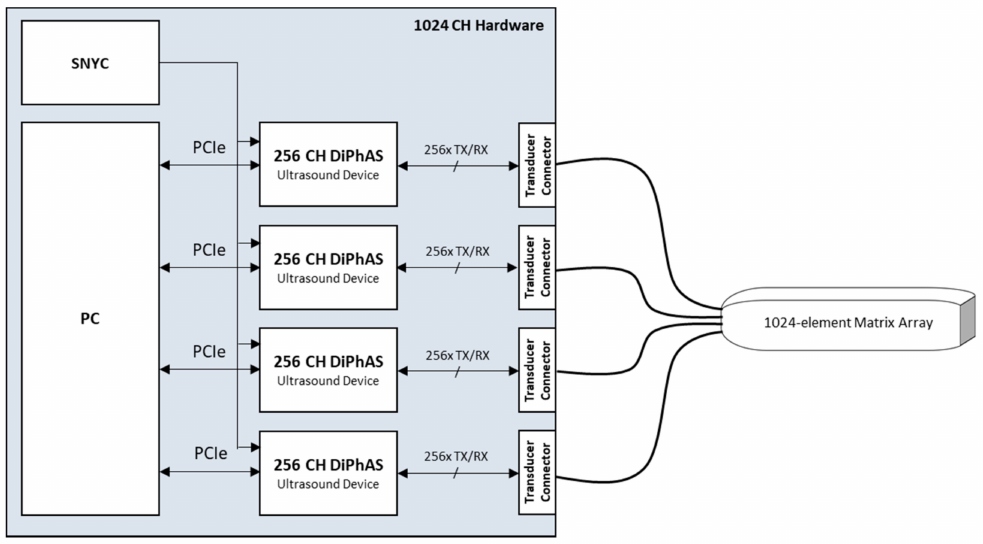
Figure 1. Simplified system architecture of the overall 1024-channel